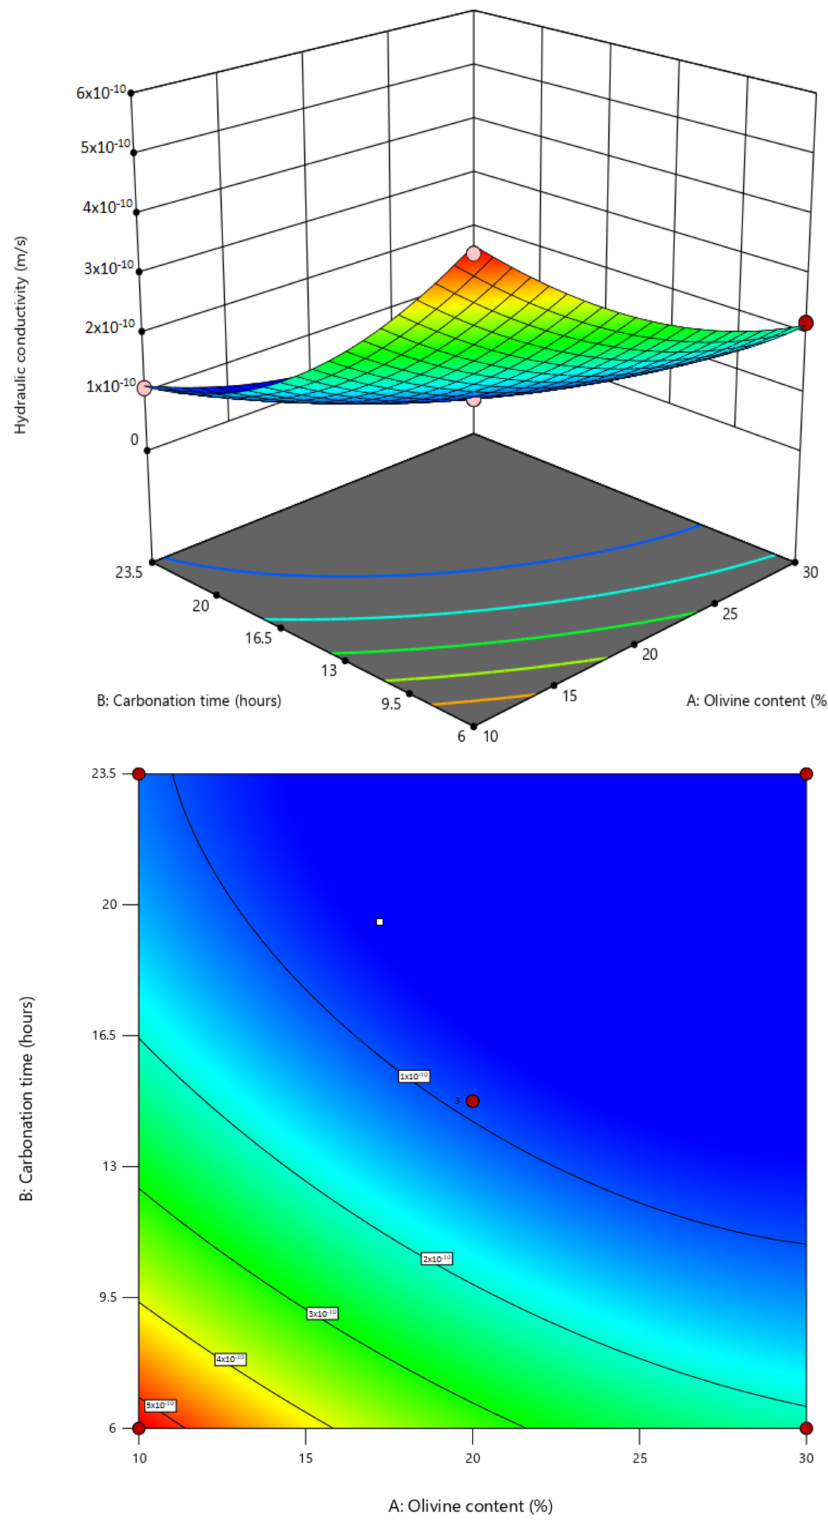
Figure 9. Response surface and contour plots demonstrating the interactive effects of carbonation time and carbonation pressure on the hydraulic conductivity while keeping olivine content at central